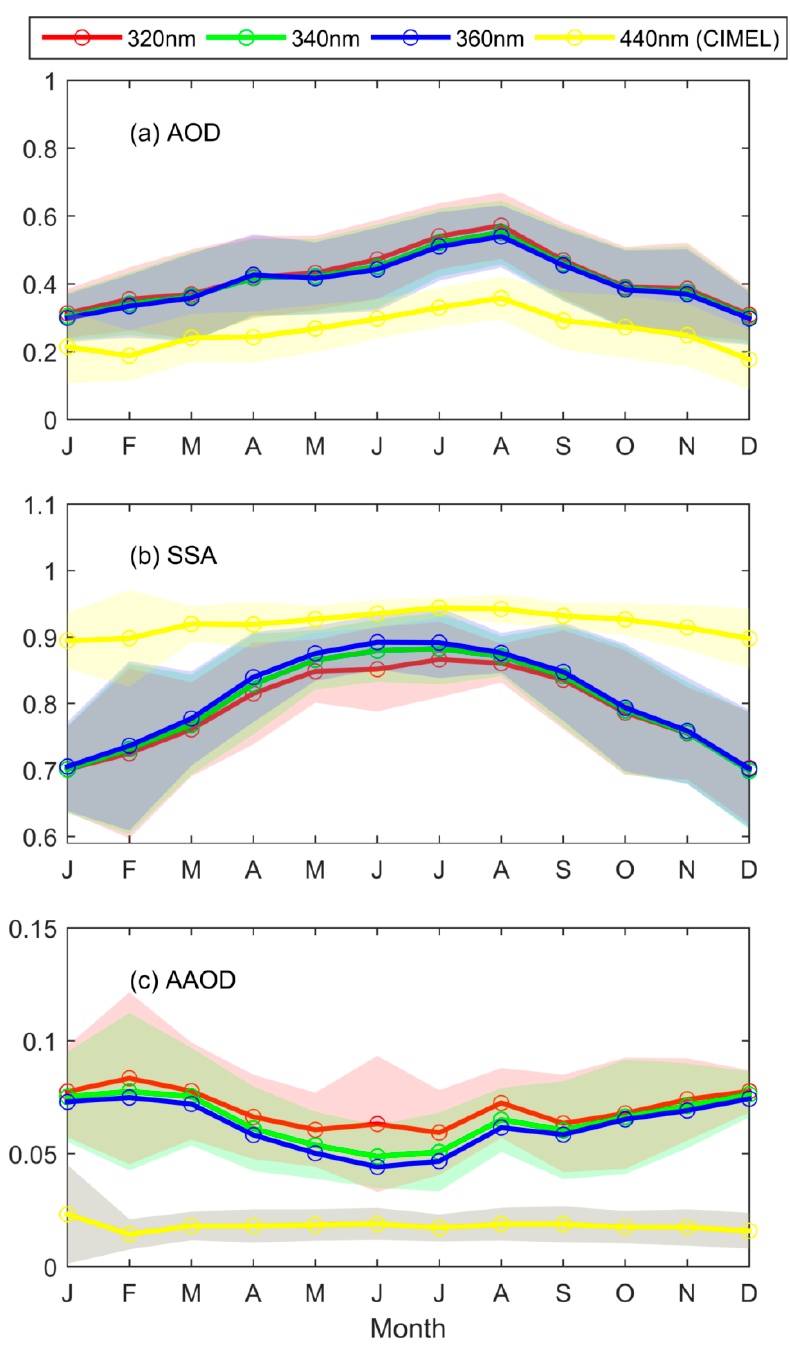
Figure 3. Long-term monthly averages of ( a ) AOD, ( b ) SSA, and ( c ) AAOD for the period 2005–2017. Data from Brewer#086 are shown for 320, 340, and 360 nm, and from CIMEL for 440 nm. The shaded areas represent the standard deviation envelope around the monthly averages.